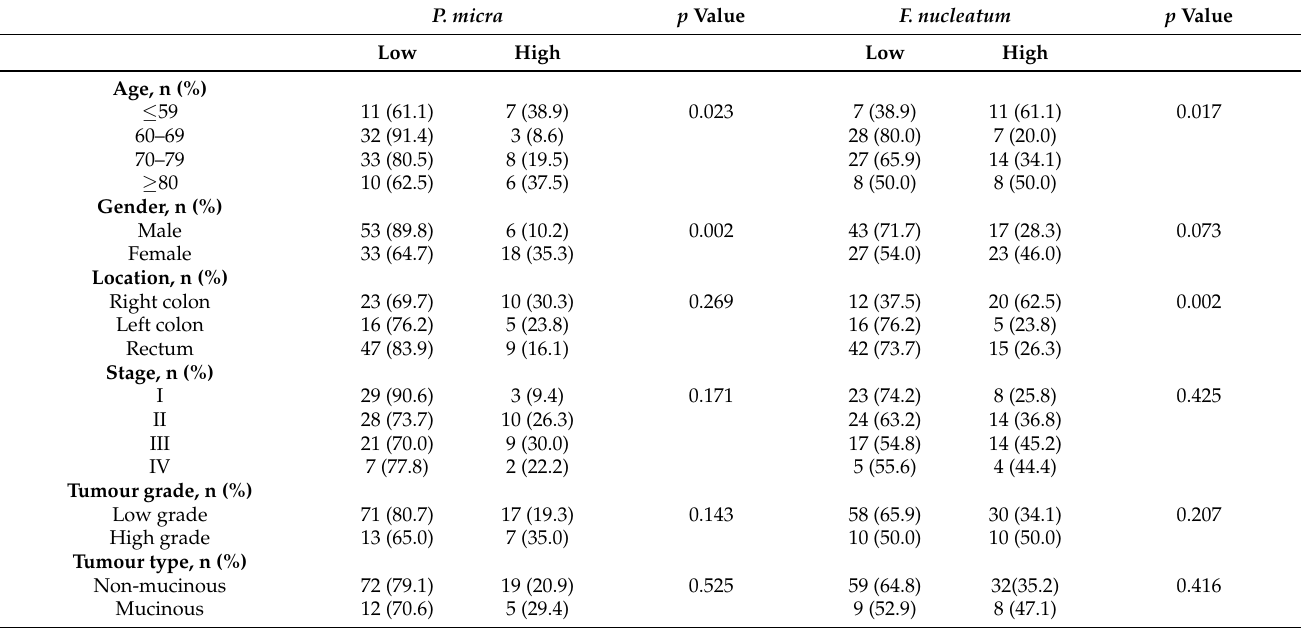
Table 2. Clinicopathological characteristics of study patients in relation to P. micra and F. nucleatum in tumour tissue. P. micra p Value F. nucleatum High